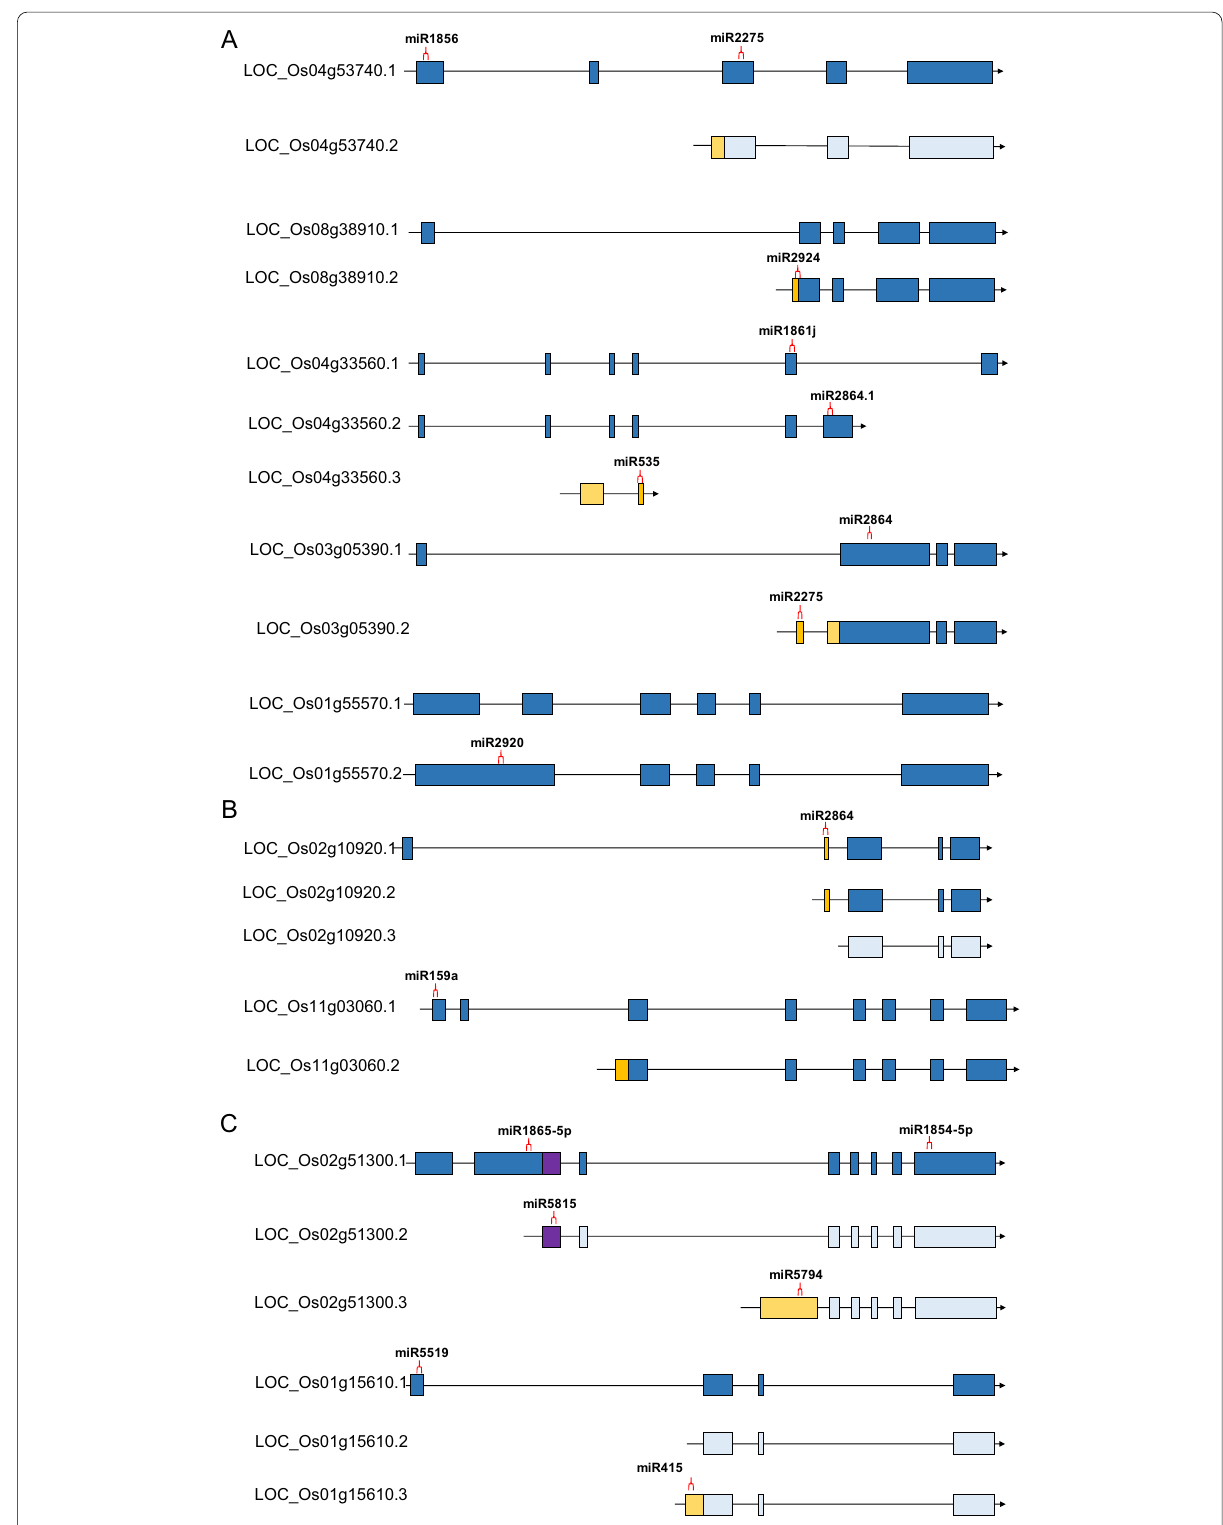
Fig. 4 Gain and Loss of miRNA Target Sites in the alternative spliced transcripts. a miRNAs loss or gain targets site caused by the intron retention (IR) alternative splicing events. b miRNAs could loss or gain targets site caused by the exon skipping (ES) alternative splicing events. c miRNAs could loss or gain targets site because of the either IR or ES alternative splicing events. The miRNA target sites were indicated in the red